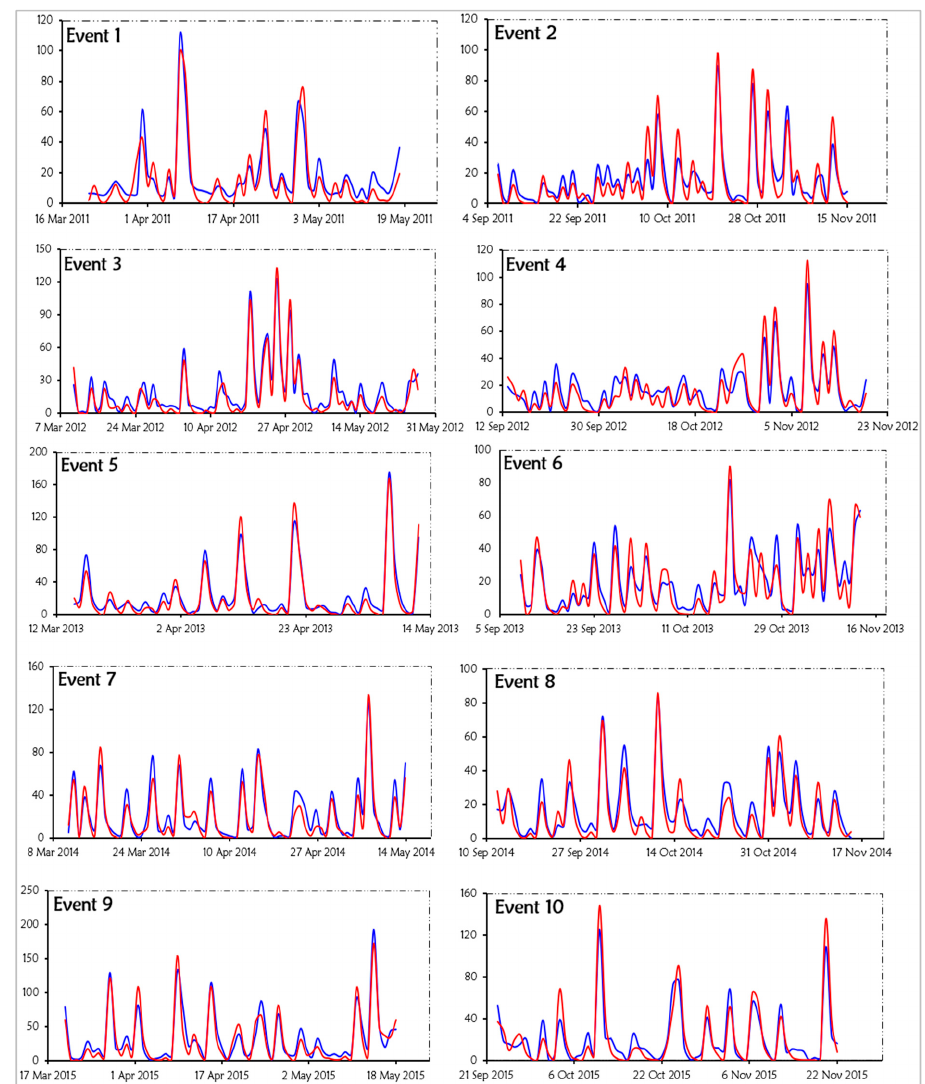
Figure 6. Comparison between the simulated and observed flow hydrographs (calibration events). Table 5. Initial and optimized values for the parameters in the sensitivity analysis.